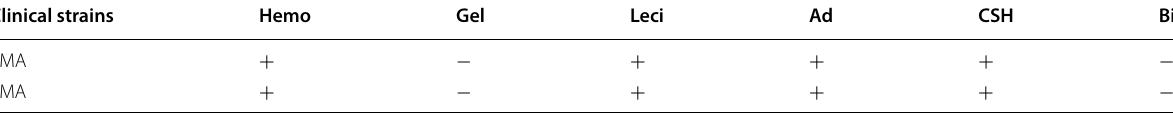
( + ): productrice; ( − ): no productrice Hemo, hemolysin; Gel, gelatinase; Leci, lecithinase; Adh, adhesion; CSH, hydrophobicity; Biof, biofilm